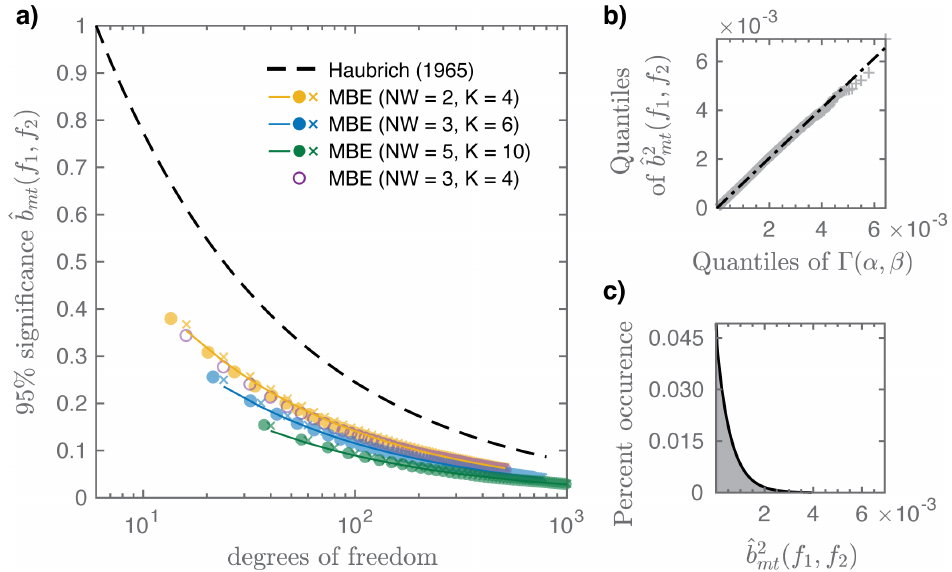
Figure A1. ( a ) the 95% significance level for zero bicoherence as a function of degrees of freedom for the adaptive (circle) and non-adaptive (x) multitaper bispectral estimator (MBE). Theoretical significance levels are represented by solid lines for time-bandwidth products NW = 2, 3, 5 with K = 2 NW tapers, as is the 95% confidence bound (dashed) for the traditional segment-averaged technique detailed ( f ) using the adaptive MBE for NW = 3 by Haubrich [51]; ( b ) quantile–quantile plot of ˆ b 2 1 , f 2 mt ( K = 6) versus a theoretical gamma distribution (equivalently a scaled χ 2 distribution) and ( c ) the 2 maximum-likelihood estimate fit of a gamma distribution (parameters in Table